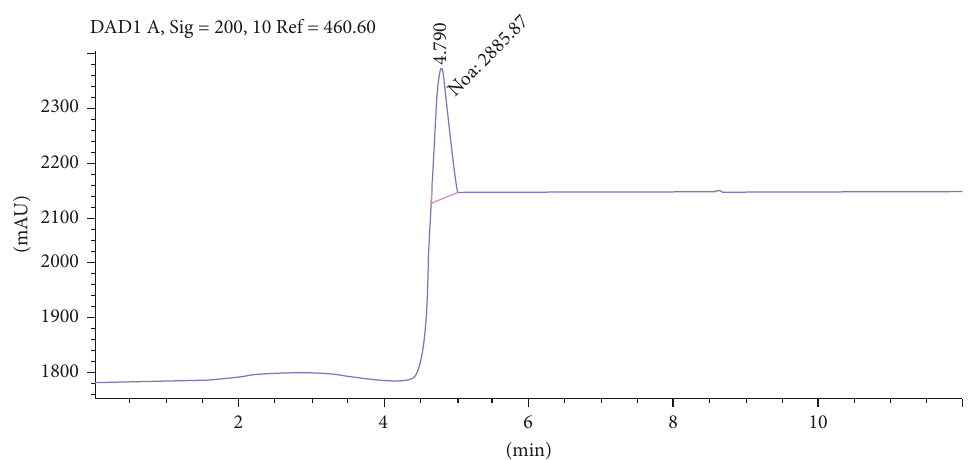
Figure 3: Glucose peak of the P1 sample and relative retention time ( T